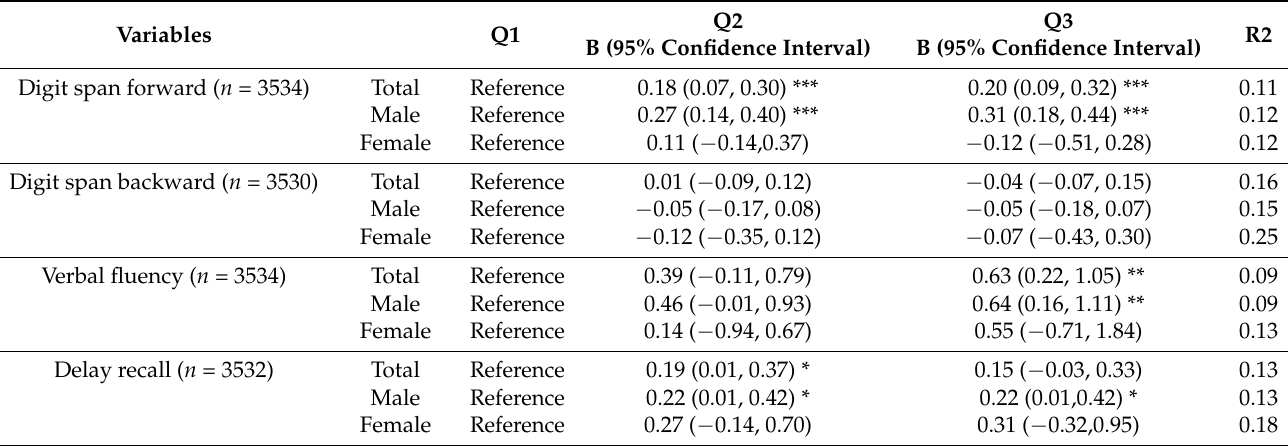
Table 3. Regression models of the association between handgrip strength or covariates and the indices of cognitive performance in adults with